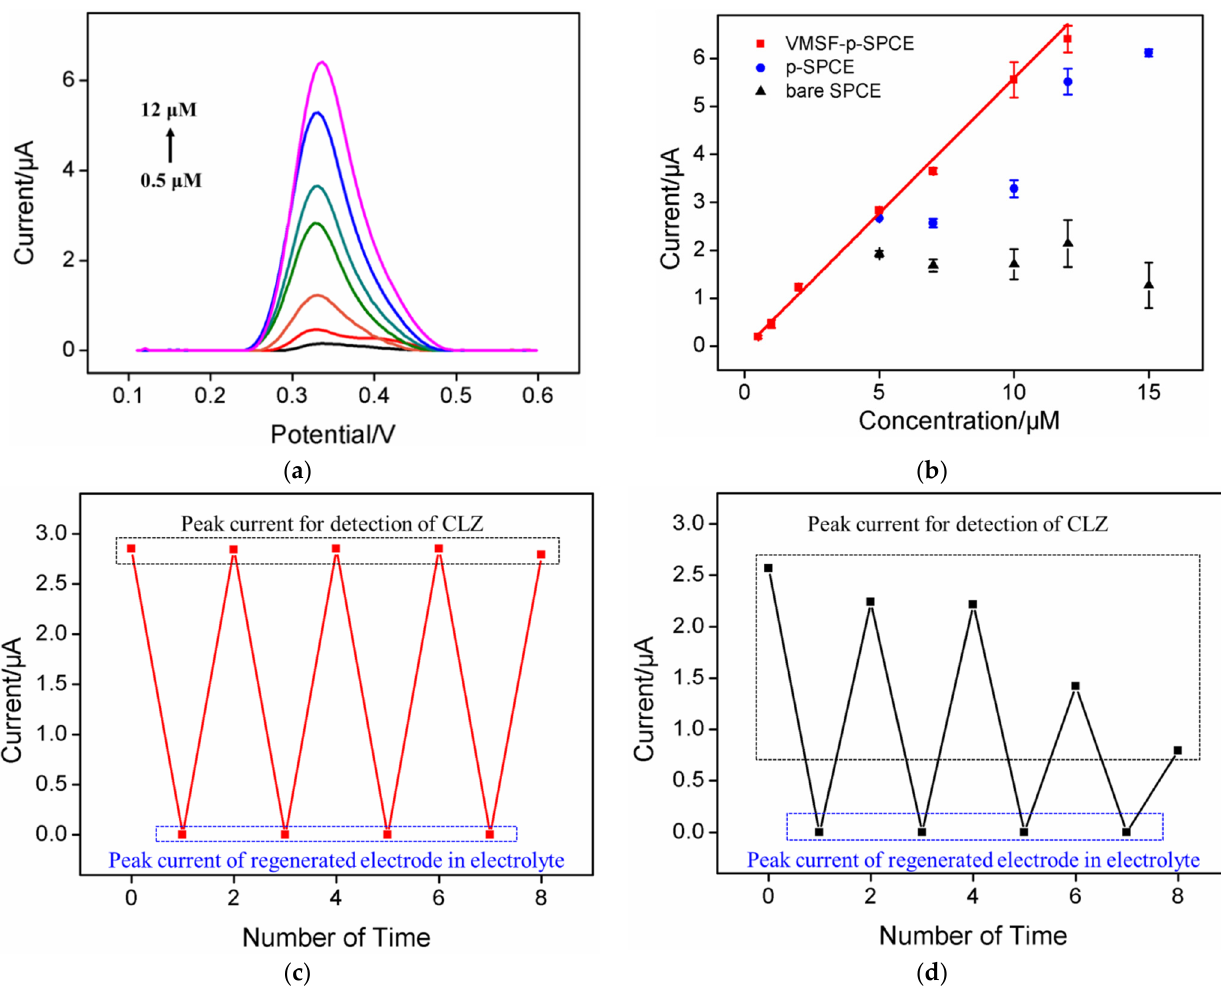
Figure 7. ( a ) DPV curves obtained on VMSF/p-SPCE in diluted human whole blood with the addition of different concentrations of CLZ (from bottom to top: 0.5, 1, 2, 5, 7, 10, 12 µ M). ( b ) The corresponding calibration curve obtained on the VMSF/p-SPCE and DPV peak currents obtained on both the p-SPCE and bare SPCE. The regeneration and reuse performance of the VMSF/p-SPCE ( c ) and p-SPCE ( d ). The first peak current was obtained using the original electrode. Other peak currents were obtained in electrolyte ( bottom ) or CLZ solution ( top ) using the regenerated electrodes. The detected CLZ was 5 μ M in diluted human blood (i.e., by a factor of 100).